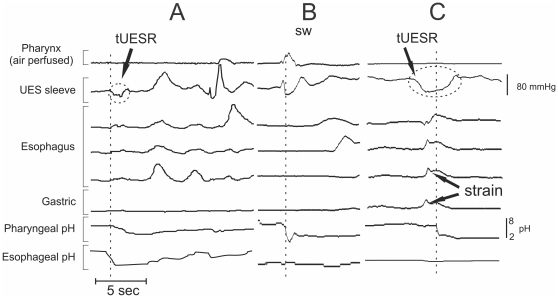
Examples of esophago-pharyngeal regurgitation events.A) Transient UES relaxation (tUESR) occurs shortly after gastro-esophageal reflux, resulting in a rapid fall of pharyngeal pH. Acid is cleared from the pharynx by a swallow; B) Acid regurgitation associated with a swallow occurring during a period of prolonged esophageal acid exposure; C) Strain-related pharyngeal acid regurgitation seen to occur shortly after a preceding UESR – both occurring during a period of prolonged esophageal acid exposure (right).